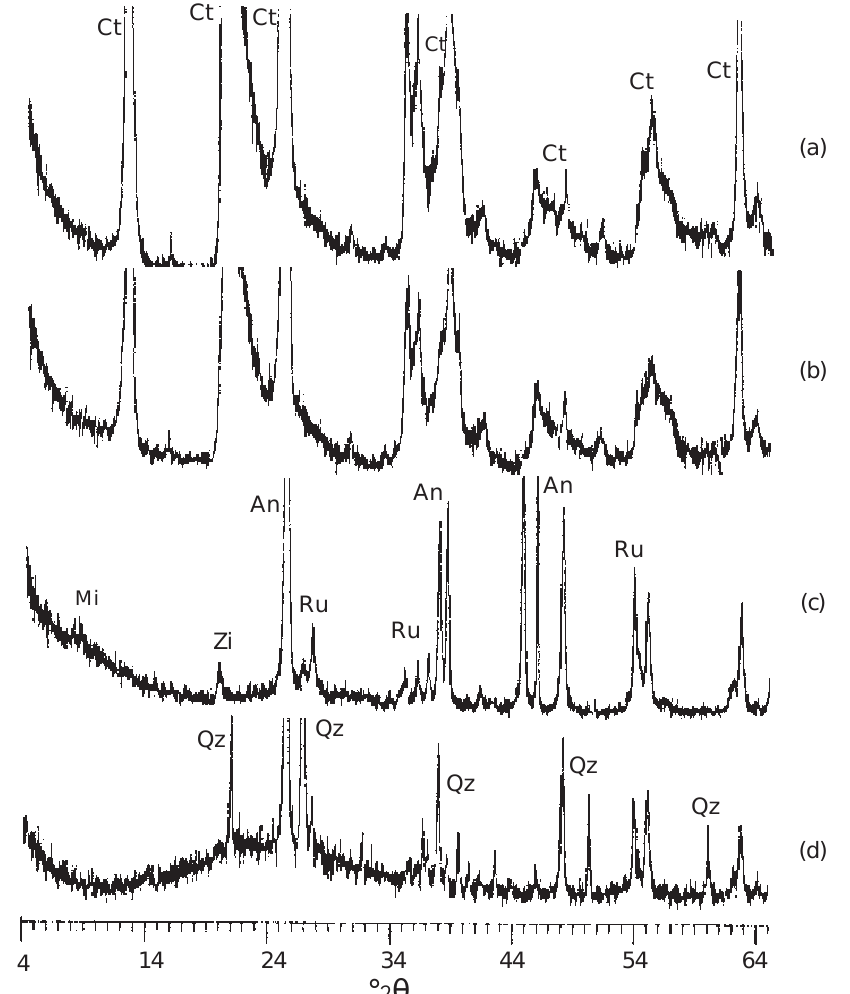
Figura 4. Difratogramas de raios-X da fração argila (amostra orientada) na profundidade de 14 m em sedimentos do Grupo Barreiras no município de Aracruz (ES), mostrando a mineralogia com os tratamentos seqüenciais (a) sem tratamento, (b) após DCB, (c) após NaOH 5 mol L -1 fervente e (d) após NaHSO : Ct - caulinita, Mi - mica, Zi - zircão, An - anatásio, Ru - rutilo e Qz - 4